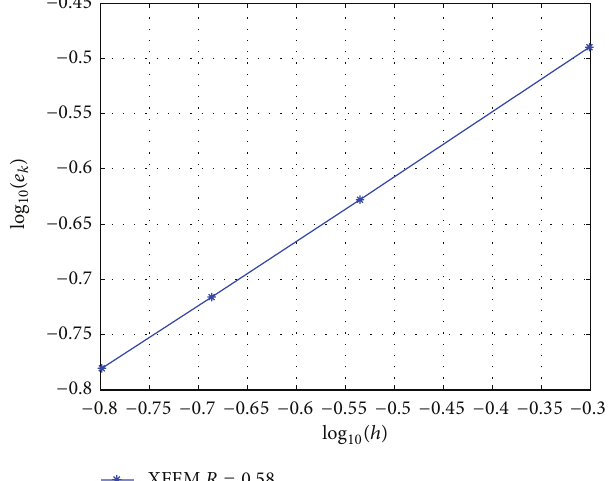
XFEM R = 0.21 Figure 23: The convergence in the stress intensity factor 𝐾 𝐼𝐼 of XFEM versus ℎ (mesh size) for sheet with edge crack under